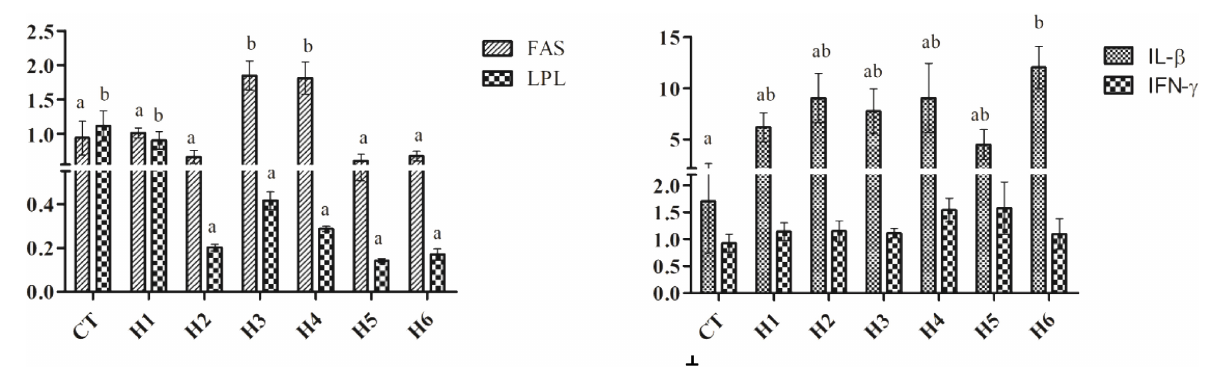
FIGURE 2 | Effect of HFP on the expression of FAS , LPL , IL - β , and IFN - γ in the hepatopancreas of juvenile pearl gentian hybrid grouper. FAS , fatty acid synthase; LPL , lipoprotein lipase; IL - β , interleukin beta; IFN - γ , interferon-gamma.